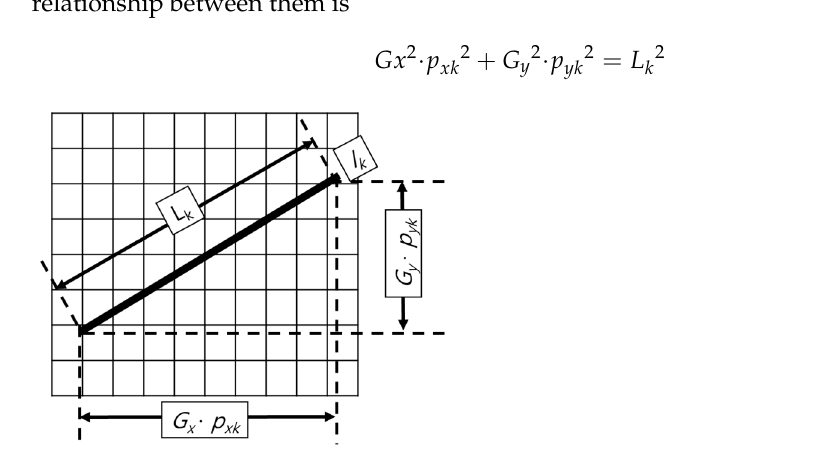
Figure 7. Procedure to estimate image coincidence.